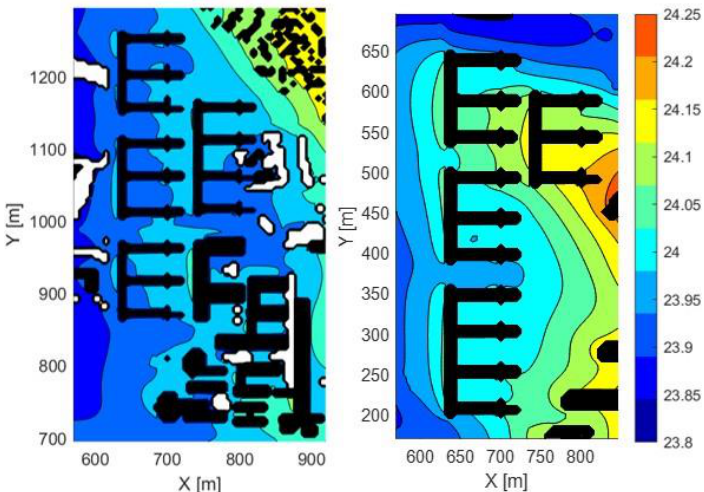
Figure 15. Comparison of the air temperature [°C] at pedestrian level in the new buildings and in the existing ones: on the left, the northern complex of proposed buildings with the old Campus; on the right, the southern complex of proposed buildings.